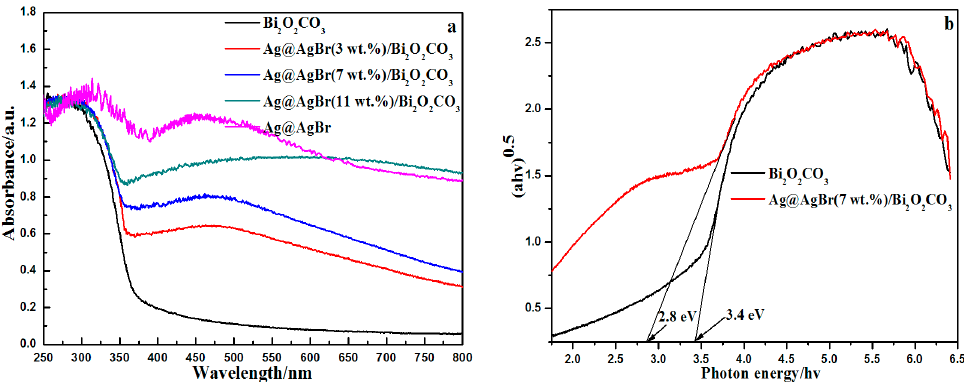
Figure 4. ( a ) UV-vis absorption spectra of the samples; and ( b ) ( α h ν ) 1/2 vs. photon energy (h ν ) curves of Bi 2 O 2 CO 3 and Ag@AgBr(7 wt %)/Bi 2 O 2 CO 3 .